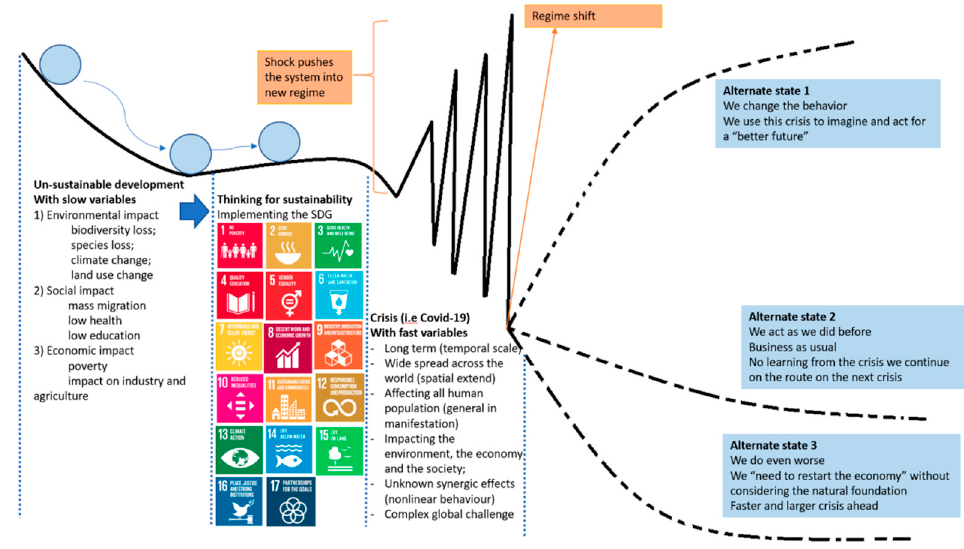
Figure 8. Possible regime shifts due to the combined impact of slow and fast variable on the system dynamics.